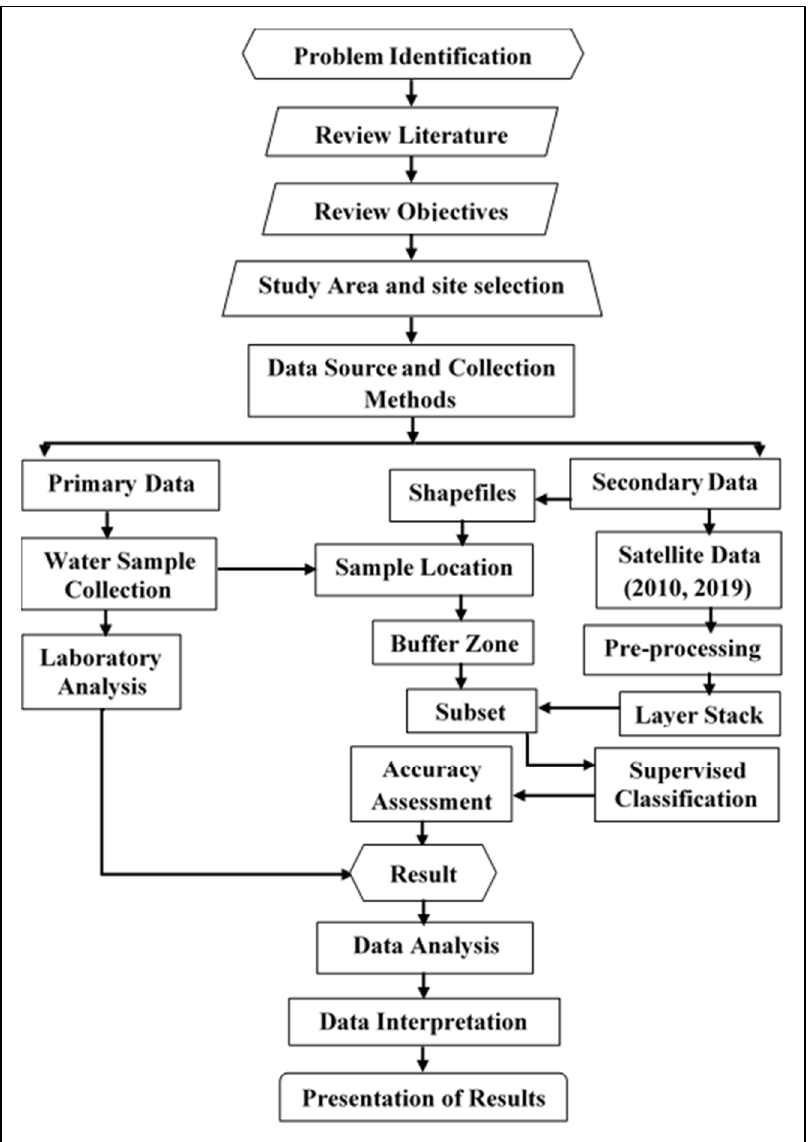
Figure 1. Research